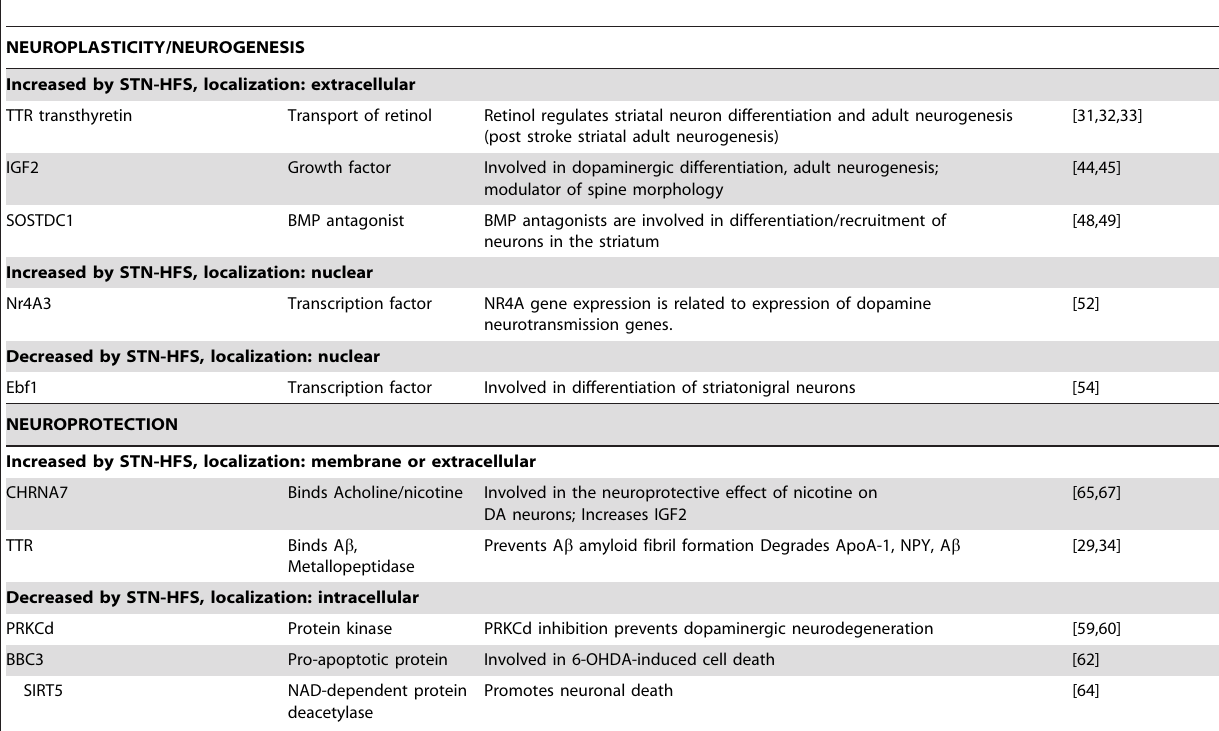
Table 3. Functional implications of the products of the genes differentially expressed after STN-HFS in link with neuroplasticity, neurogenesis or